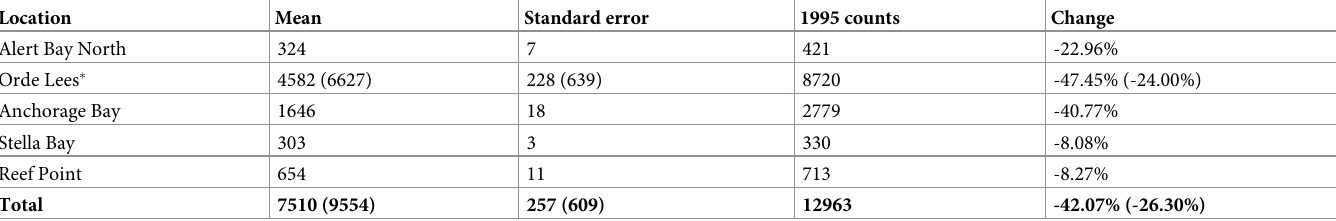
Table 3. Erect-crested penguin population